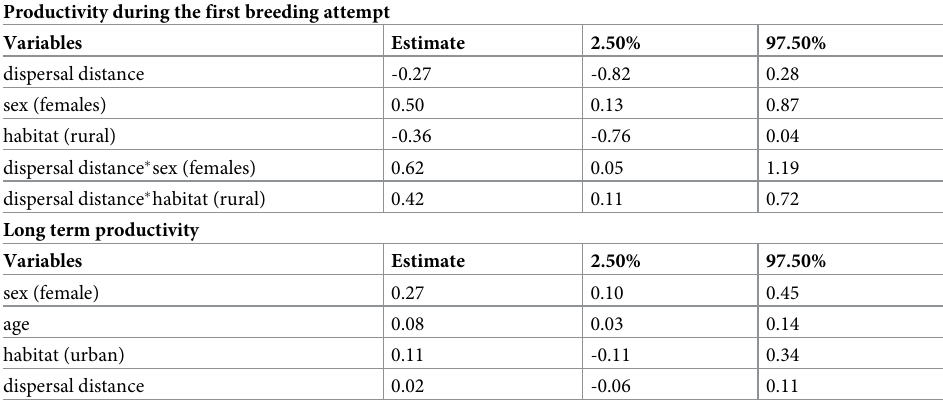
Table 4. Estimates and 95% confidence intervals (2.5% and 97.5%) obtained after model averaging to assess the relationship between natal dispersal distances and productivity during the first breeding attempt, and long term productivity of rural and urban (habitat) burrowing owls Athene cunicularia . We considered that a given variable has no, weak or strong support when the 95% confidence interval strongly overlapped with zero, barely overlapped with zero (asterisk), or did not overlap with zero (in bold), respectively. Results remained unchanged when model aver- aging was performed using all candidate models, not only those with Δ AICc < 2 (S3